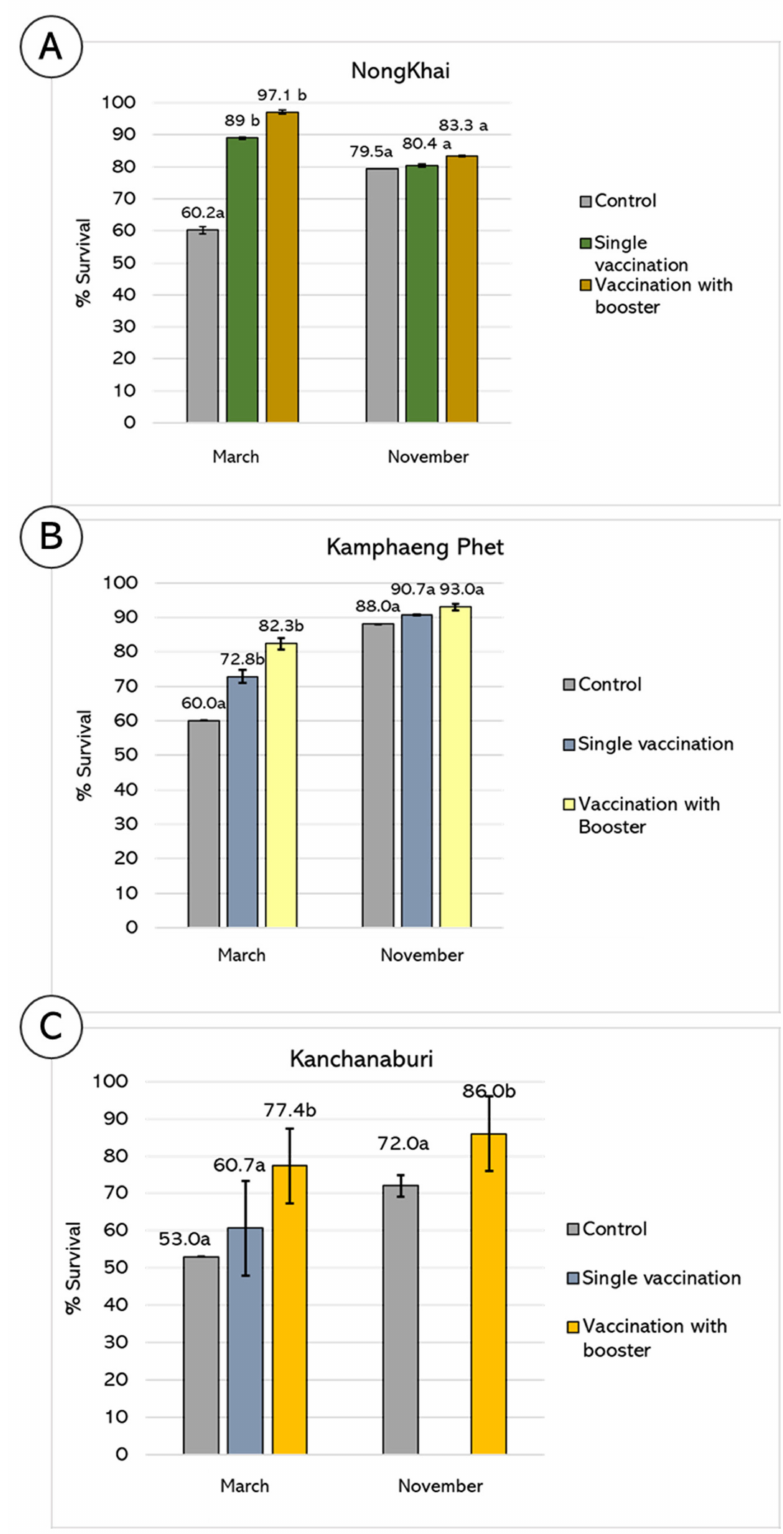
Figure 7. Field trial of bivalent streptococcal vaccine in 3 different locations in Thailand. Percent survival of Nile tilapia after single vaccination or vaccination with booster was evaluated in March and November 2015. ( A ) Survival rates of vaccinated tilapia in Nong Khai province. ( B ) Survival rates of vaccinated tilapia in Kamphaeng Phet province. ( C ) Survival rates of vaccinated tilapia in Kanchanaburi province. a, b = significant difference between treatment group in each month ( p <